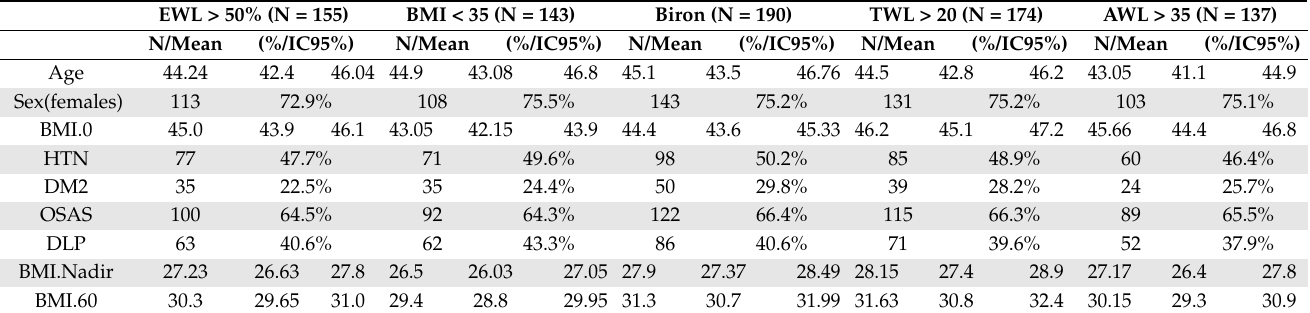
Table 3 show the success criteria rates for the different techniques performed. Table 3 is for patients in the LSG group. The highest rates for LSG groups are for the Biron (85%) and TWL (78%) criteria. The preoperative BMI is 44.4 and 46.2, and at 5-year follow-up, 31.3 and 31.6, respectively. Table 4 is for patients in the RYGB group, where higher success rates are calculated. In this group, higher success rates are obtained by the Biron (96%), TWL (90%), and EWL (88%) criteria. Table 3. Success rates for different criteria at 5-year follow-up for sleeve gastrectomy interventions. Data are reported as mean and 95% confidence interval (CI 95%) or n (%). N, number of individuals; BMI.O, BMI before surgery; BMI.nadir, BMI at nadir post-bariatric surgery; BMI.60, BMI at 5-year post-bariatric surgery; HTN, hypertension; DM2, diabetes mellitus type 2; OSAS, obstructive apnea syndrome; DLP, dyslipidemia.